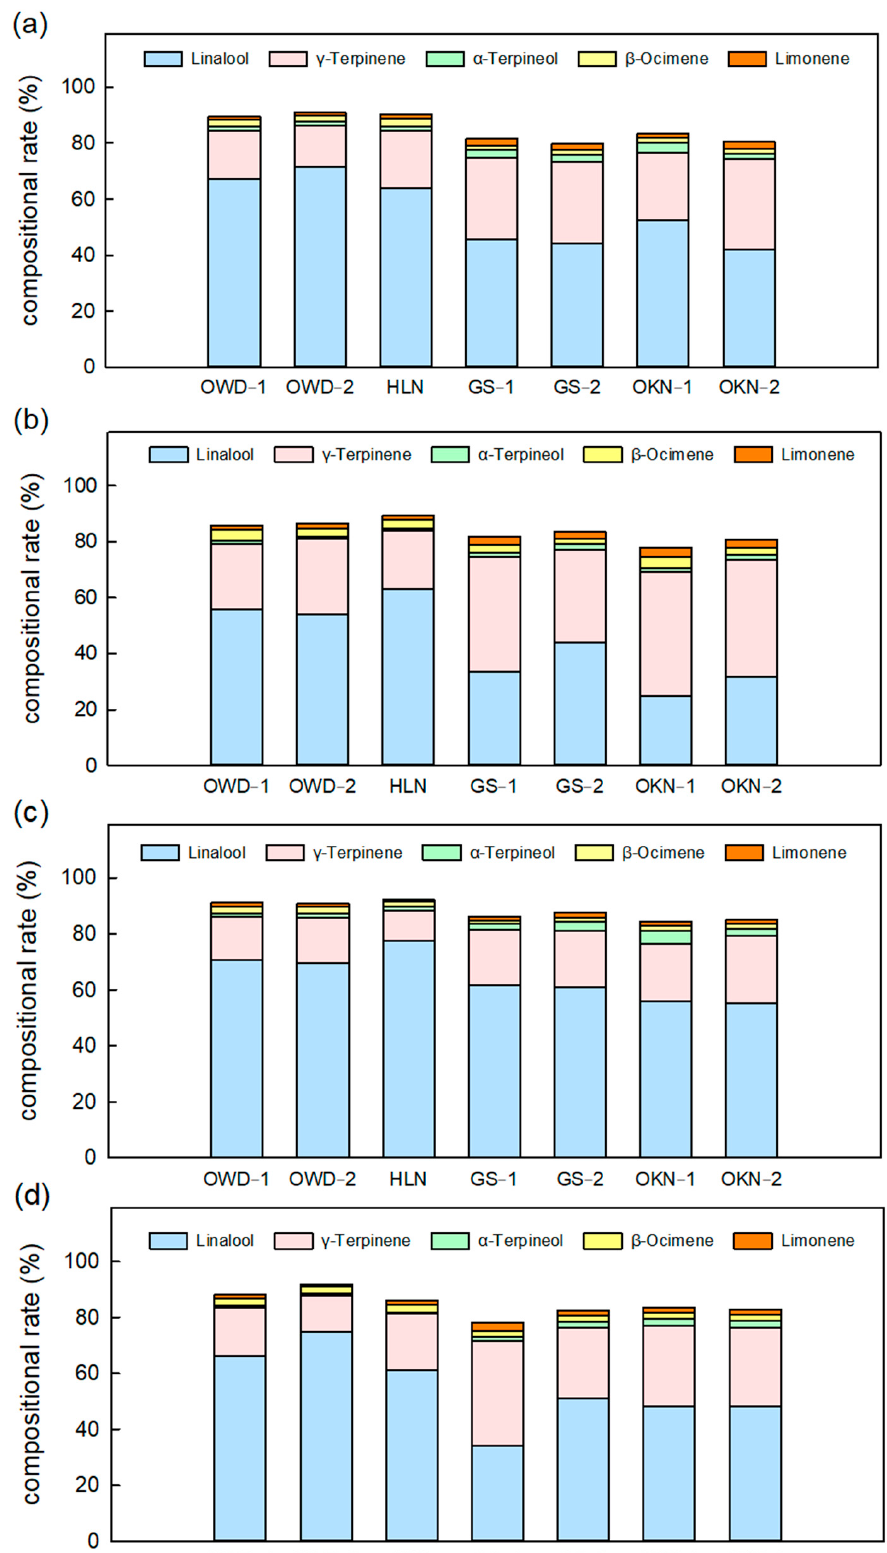
Figure 6. The compositional rate of major volatile compounds of Citrus depressa fresh leaf among all accessions in all seasons, which is ( a ) spring; ( b ) summer; ( c ) autumn; and ( d ) winter. Each bar shows the average ( n = 3) of the relative concentration (rel. conc.) The error bar was calculated by standard errors, and the different letters show a significant difference (LSD p < 0.05).